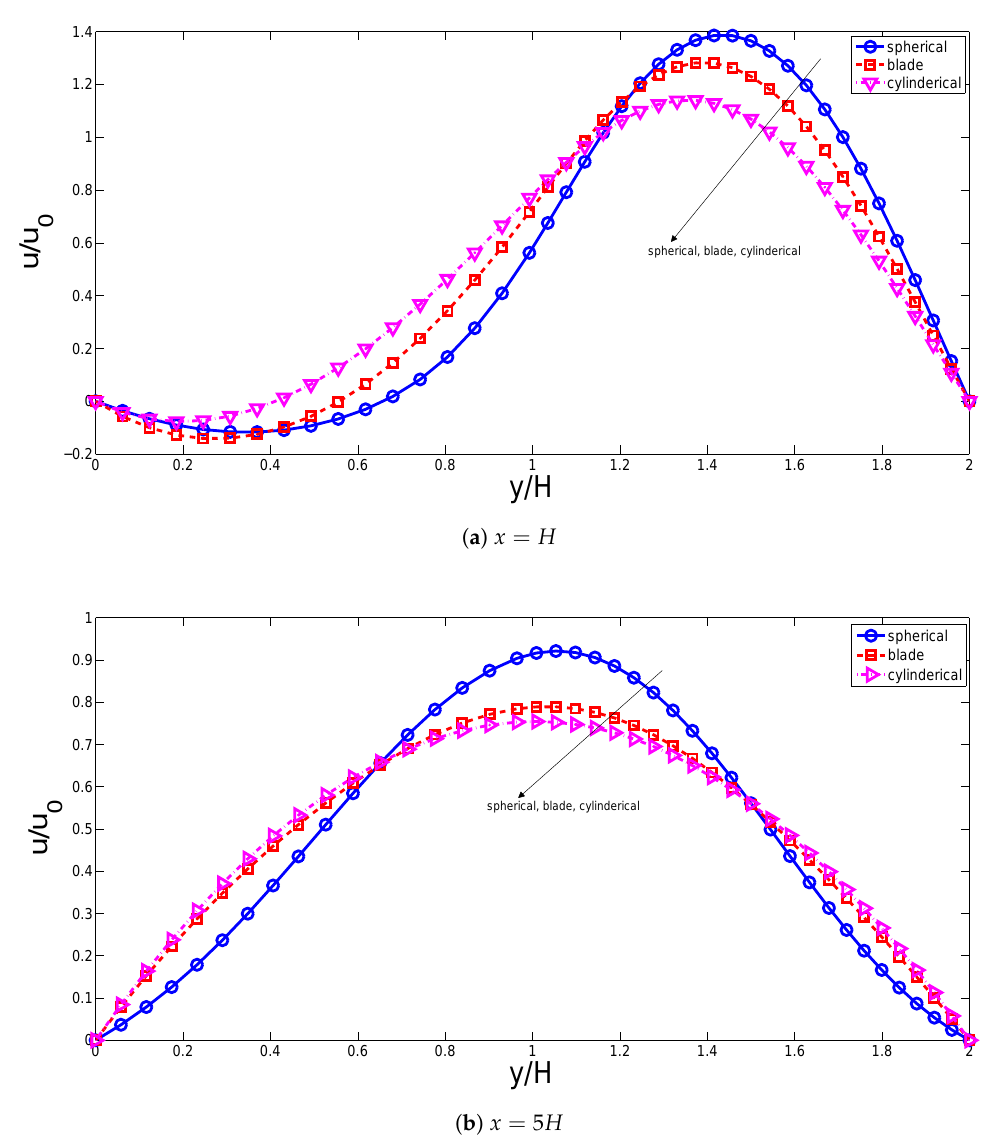
Figure 3. Variation of the x component velocity along the y direction for various particle shapes with φ =